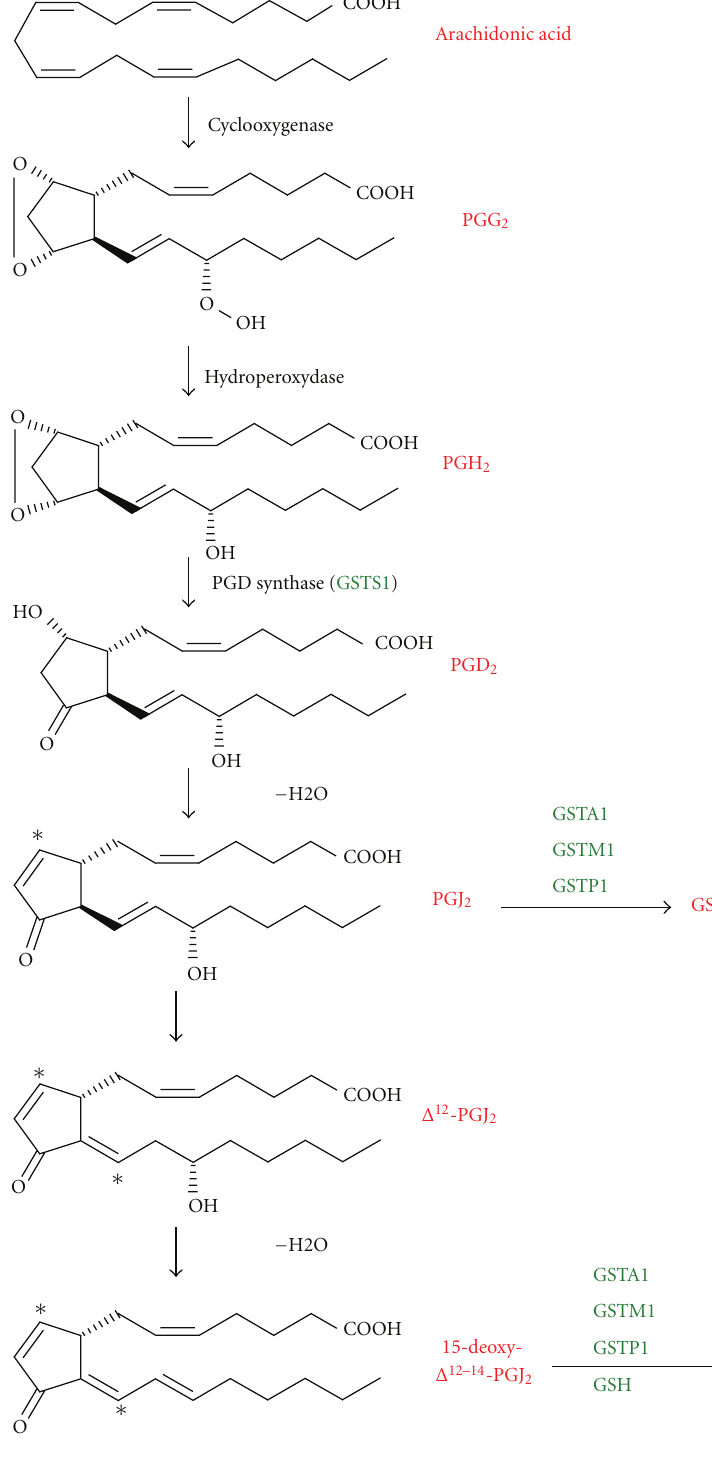
Figure 1: The prostaglandin biosynthetic pathway (adapted from [1]) 15-deoxy Δ 12 − 14 -PGJ 2 is a metabolite derived from arachidonic acid. Several GSTs are implicated in the regulation of its formation: GSTS1 metabolized PGH2 in PGD2; GSTA1, GSTM1, and GSTP1 conjugated GSH to PGJ 2 and 15-deoxy Δ 12 − 14 -PGJ 2 . This conjugation led to the regulation of various transcription factors (PPAR γ , NF- κ B, and